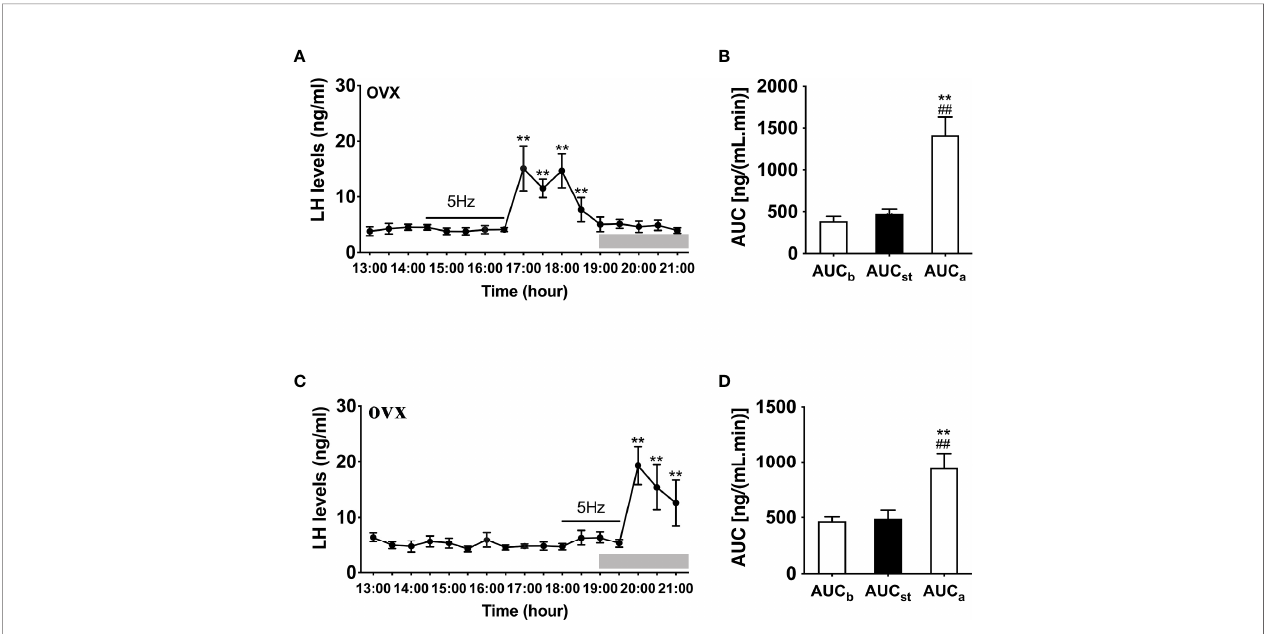
FIGURE 3 | Effects of optogenetic activation of ARC kisspeptin neurons on LH secretion in OVX Kiss-cre mice. (A) Evoked LH secretion (Mean ± SEM) in response to 5 Hz blue-light stimulations of ARC kisspeptin neuron (14:30 - 16:30 h) (n = 5). (B) Area under curve of LH levels before (basal) (AUC b , 13:00 - 14:30 h), during (AUC st , 14:30 - 16:30 h) and after stimulation (AUC a , 16:30 – 18:30 h). (C) Evoked LH secretion in response to 5 Hz optic stimulations of ARC kisspeptin neuron from 18:00 to 19:30 h (n = 5). (D) Area under curve of LH levels before (AUC b , 13:00 - 14:30 h), during (AUC st , 18:00 - 19:30 h) and after stimulation (AUC a , 19:30 - 21:00 h). **P < 0.01 (unpaired t-test) relative to basal LH levels or AUC for basal LH levels. ## P < 0.01 indicates a signi fi cant difference relative to AUC for stimulation periods. Lights off is at 19:00 h for all experiments, as indicated by the grey bar on the